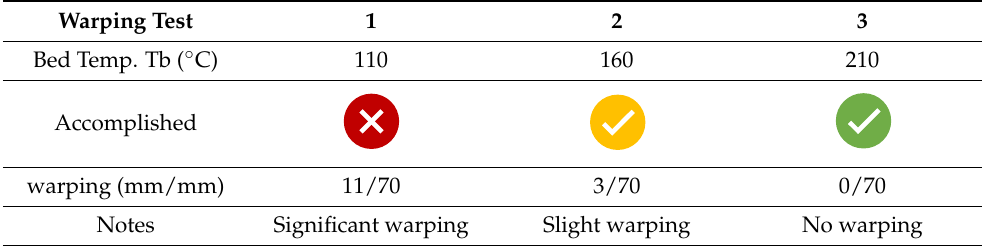
Table 4. Bed temperature sensitivity analysis results; warping is measured as the difference in height between the two sides of a 70 mm long rectangular sample.